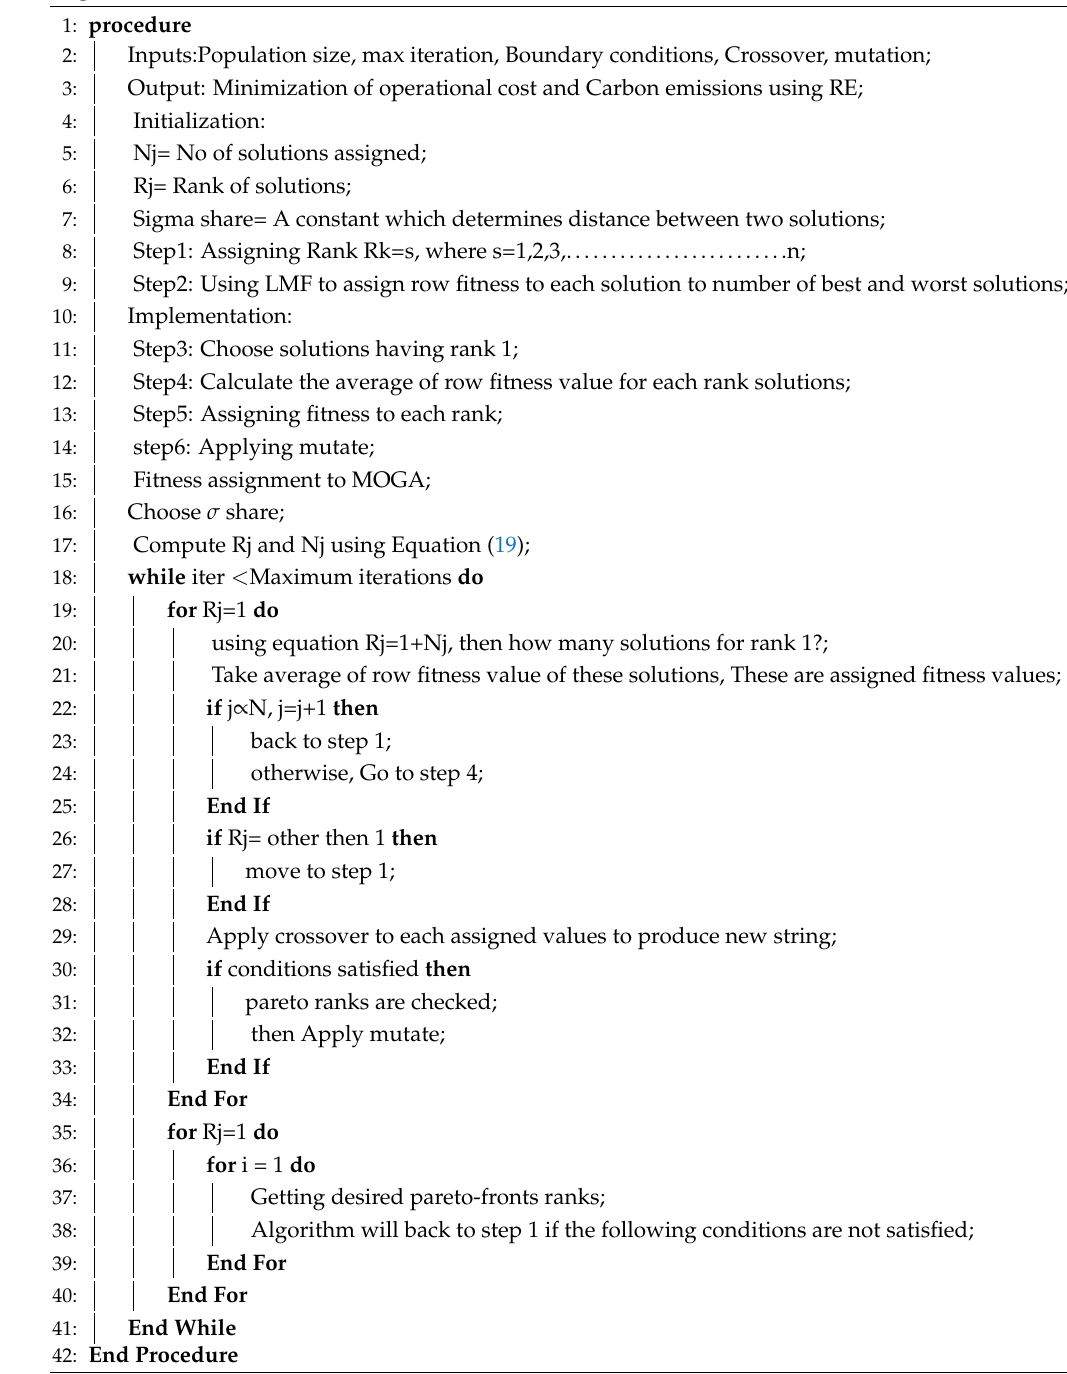
Algorithm 1 MOGA